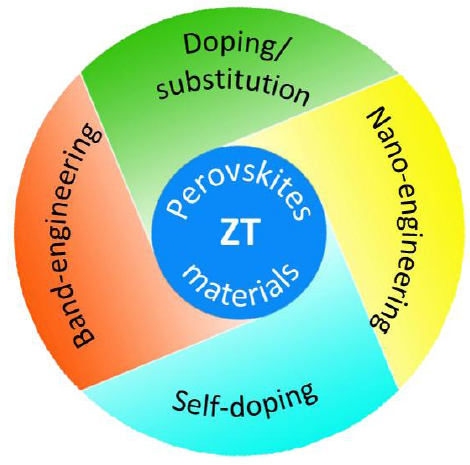
Figure 16. Possible strategies to enhance the thermoelectric ZT value of perovskite materials.